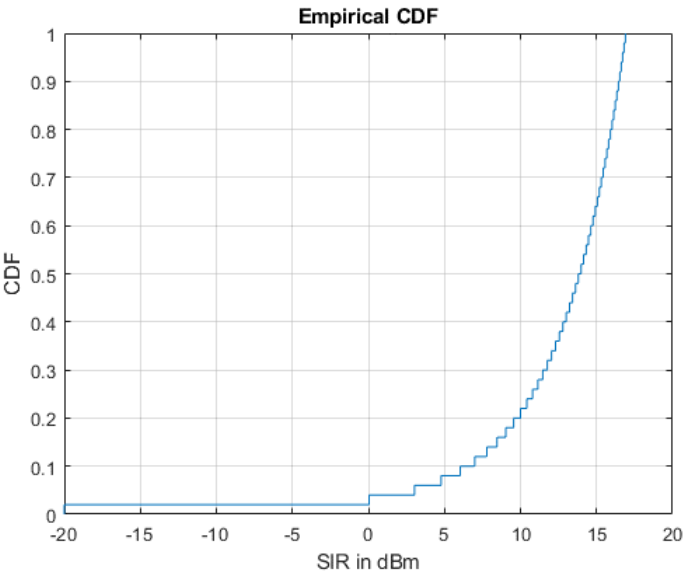
Figure 10. CDF of small cell BSs SIR with the IMHC hybrid clustering algorithm.